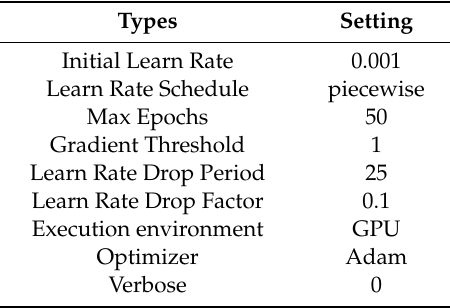
Table 3. Hyperparameter settings of long short-term memory (LSTM)